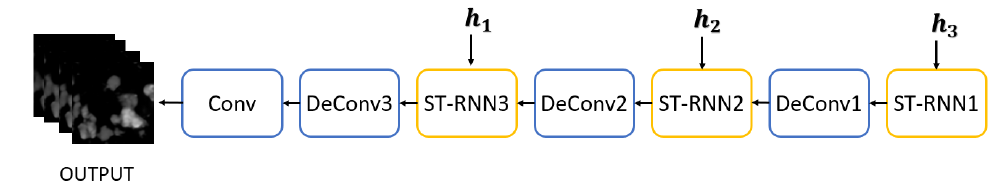
Figure 4. ThedecoderstructureofSTPNet, includingthreestackedST-RNNlayersandupsampling Figure 4. The decoder structure of STPNet, including three stacked ST-RNN layers and upsampling layers.